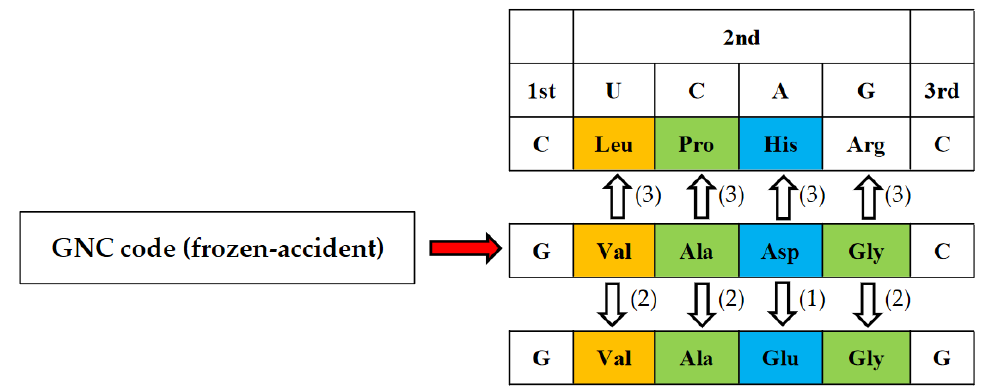
Figure 8. After GNC code was established as the GNC code frozen-accident theory assumes, the GNC code expanded from four GNC codons to capture GNG codons and CNC codons as coevolution theory [23,24] and adaptive theory [27] expects [1]. The order of the evolutionary pathway is indicated by numerals (1), (2), and (3). Amino acids in brown, green and blue boxes mean hydrophobic, intermediate and hydrophilic amino